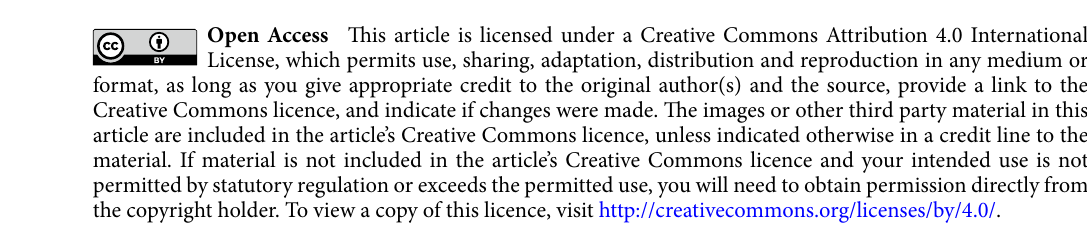
Figure 3. ( a ) Example of 6 8-bit inputs FLP adder tree. ( b ) Architecture of a FLP adder. ( c ) Architecture of the optimized FLP adder used in the first level of the